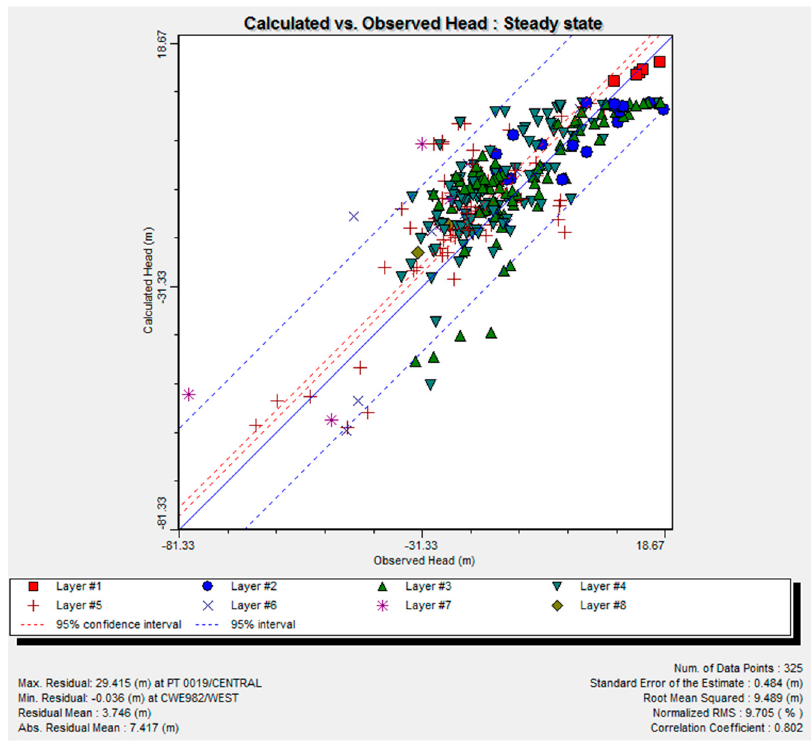
Figure 12. Calibrated results of the groundwater level model in the study area.